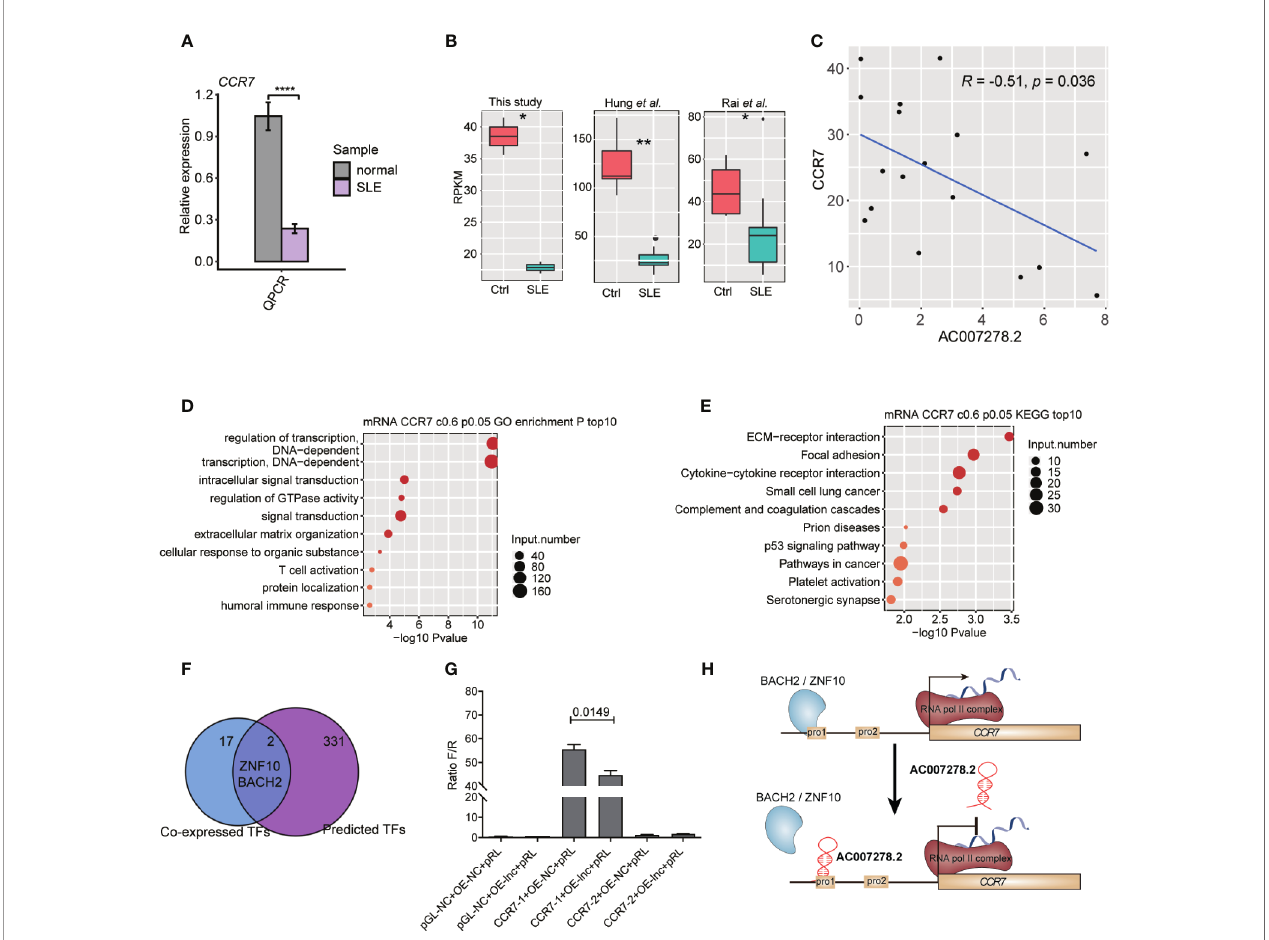
FIGURE 6 | AC007278.2 negatively regulates CCR7 expression. (A) Bar plot shows quantitative reverse transcription-polymerase chain reaction (RT-qPCR) experiment results of increased CCR7 expression level in SLE patients and normal controls (n = 5, mean ± SD). (B) Box plot shows the repressed CCR7 expression level in systemic lupus erythematosus (SLE) patients from three datasets. (C) Dot plot shows the negative correlation between AC007278.2 and CCR7 . The line represents the regression line. (D) Bubble plot shows the top 10 enriched Gene Ontology biological process terms for genes that were co-expressed with CCR7 . (E) Bubble plot shows the top 10 enriched Kyoto Encyclopedia of Genes and Genomes pathways for genes that were co-expressed with CCR7 . (F) Venn diagram shows the overlapped co-expressed and GeneHancer-predicted transcription factors (TFs) for CCR7 . (G) Bar plot shows the transcriptional repression function of AC007278.2 on the fi rst CCR7 promoter (mean ± standard deviation, two-tailed unpaired t -test). PGL-NC represents empty plasmid; CCR7-1-OE and CCR7-2-OE represent CCR7 overexpression plasmid with fi rst and second promoter, respectively (n = 3, mean ± SD). (H) The predicted working model based on the fi nding that AC007278.2 negatively regulated CCR7 expression is shown. * p < 0.05; ** p < 0.01; **** p < 0.0001, two-tailed unpaired t